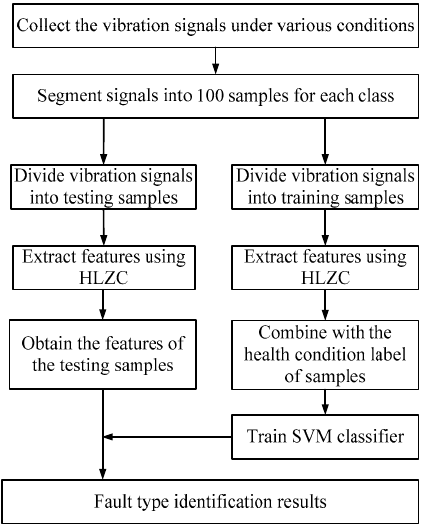
Figure 9. Flowchart of the proposed fault diagnosis method.